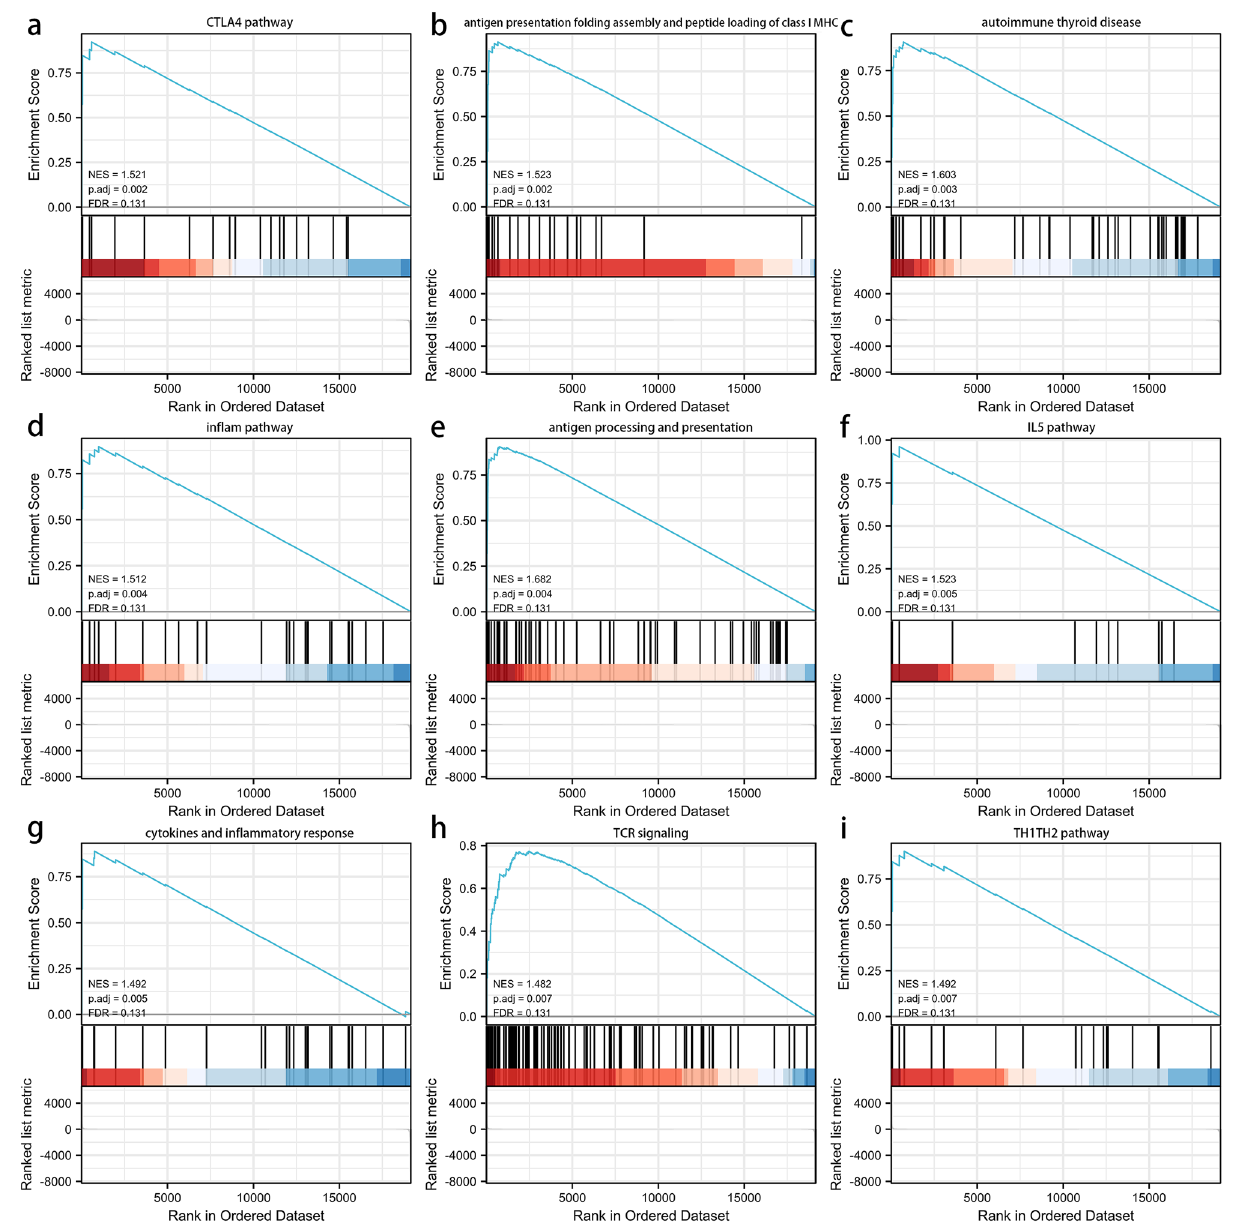
Figure 6. Gene set enrichment analysis (GSEA) about the pyroptosis-related lncRNA prognostic signature. ( a ) CTLA4 pathway. ( b ) antigen presentation folding assembly and peptide loading of class I MHC. ( c ) autoimmune thyroid disease. ( d ) inflam pathway. ( e ) antigen processing and presentation. ( f ) IL5 pathway. ( g ) cytokines and inflammatory response. ( h ) TCR signaling. ( i ) TH1TH2